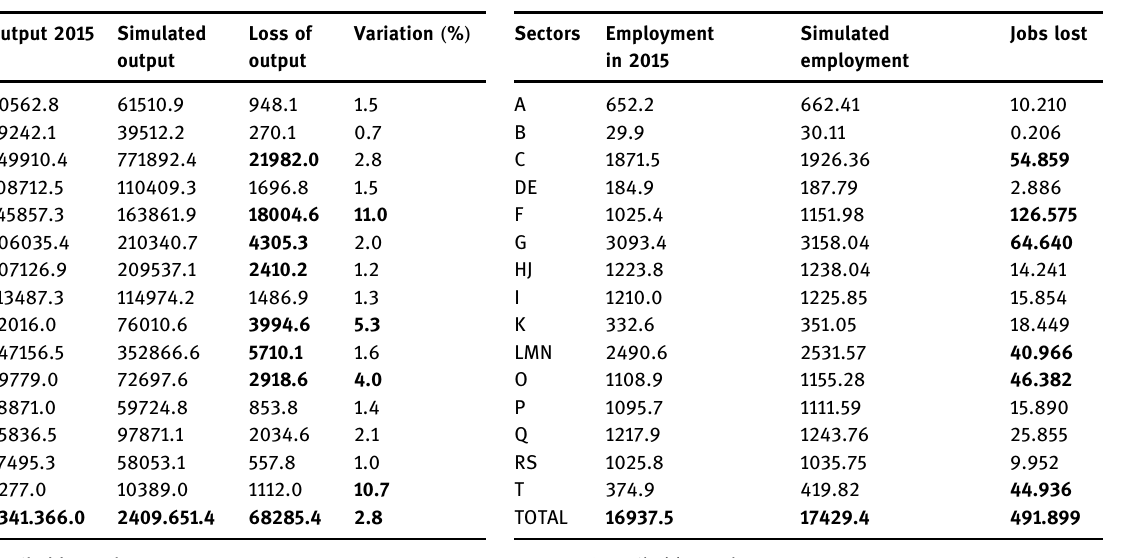
Table 6: Impact on total employment ( stated in thousands